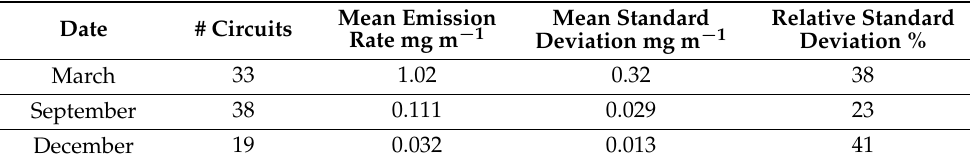
Table 2. Summary of PM 10 emission rates results from the precision test loop.